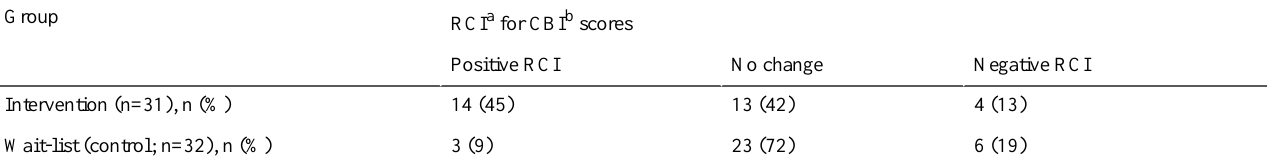
Table 4. RCI of participants in the ITT